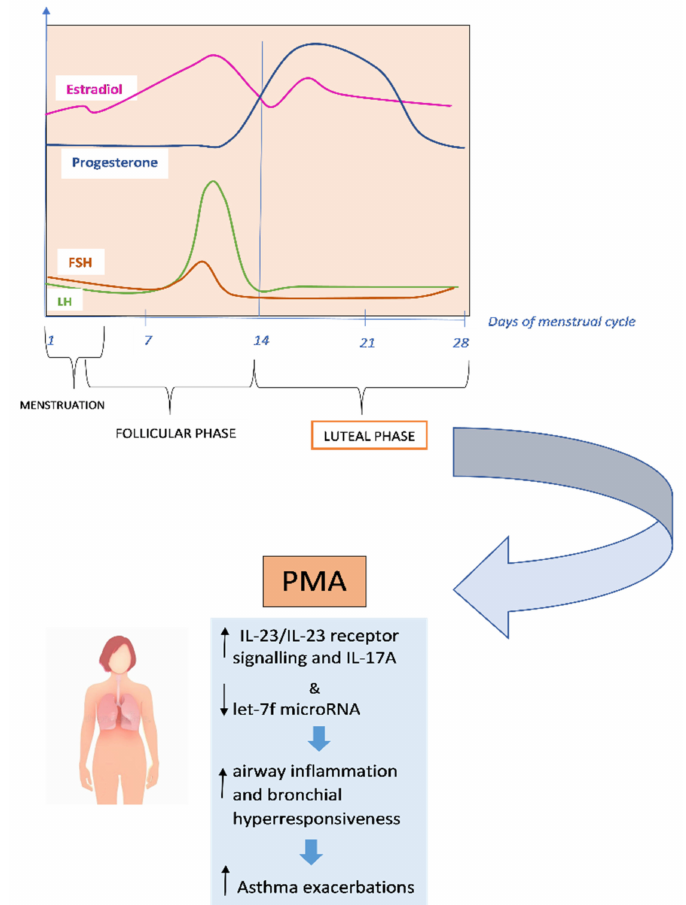
Figure 2. Underlying mechanisms of premenstrual